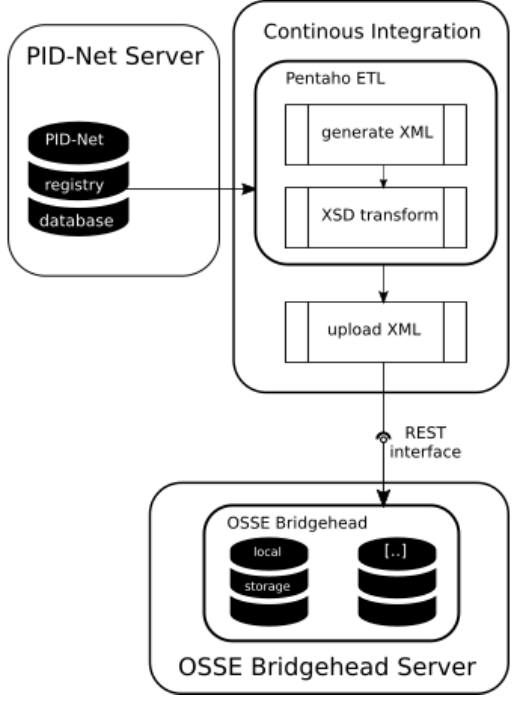
Figure 2. Connecting PID-NET via an OSSE bridgehead. The same structure could be used for any non-OSSE registry. ETL: extract, transform, and load; OSSE: Open Source Registry System for Rare Diseases ( Open-Source-Registersystem für Seltene Erkrankungen , in German); PID-NET: German Network on Primary Immunodeficiency Diseases; REST: representational state transfer; XSD: XML Schema